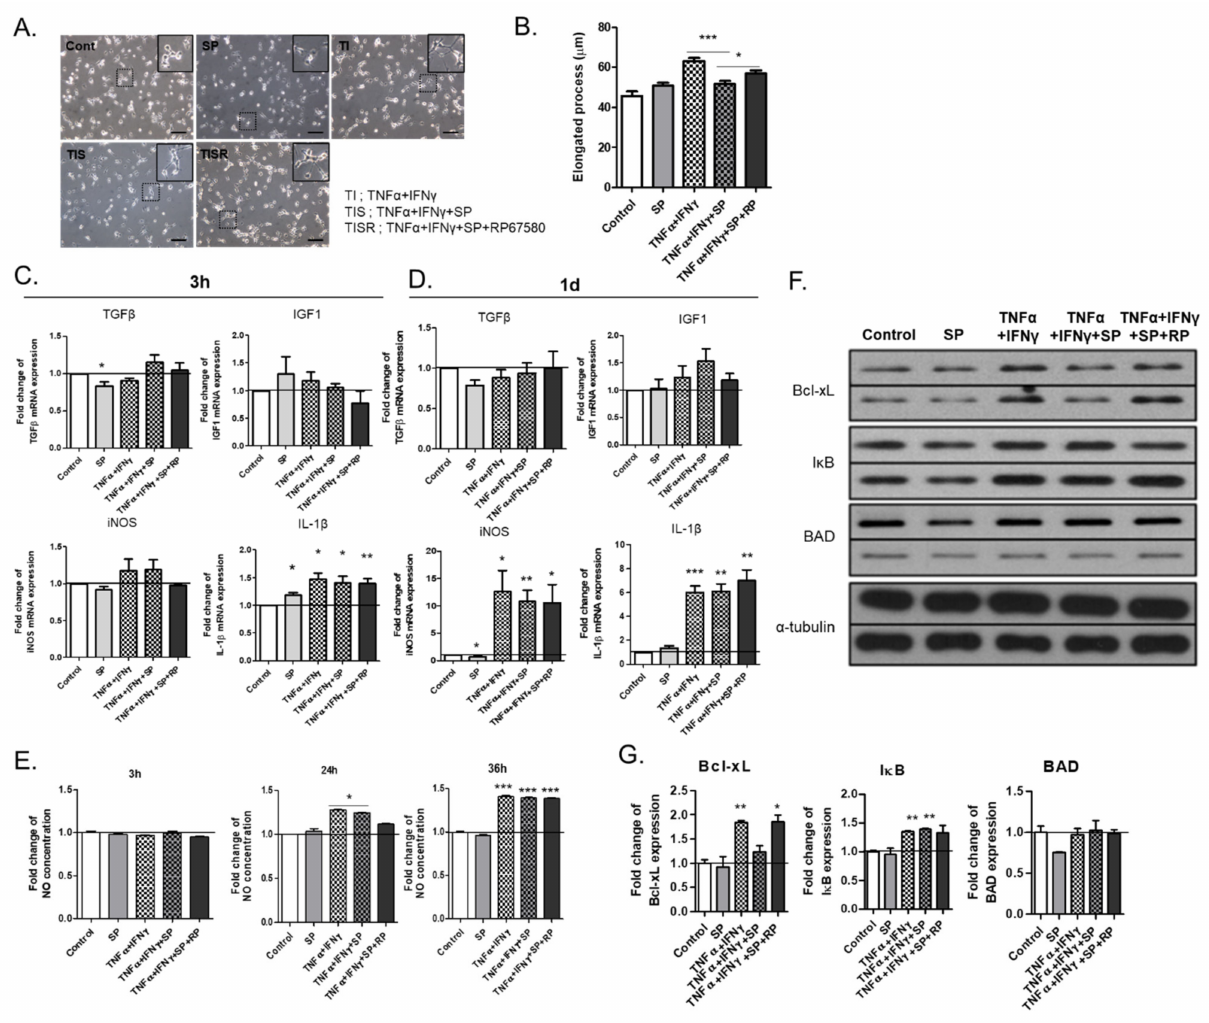
Figure 5. M1 polarization of MG d14 induced by treatment with TNF- α and IFN- γ : ( A ) Bright field images of microglia cultured with TNF- α and IFN- γ ; microglia cultured with TNF- α , IFN- γ , and SP; and microglia cultured with TNF- α , IFN- γ , SP, and RP67580 (RP, an NK1 receptor antagonist). ( B ) quantitative data for elongated processes of microglia under various cytokine treatments; ( C , D ) quantitative data for mRNA expression of TGF- β , IGF1, iNOS, and IL-1 β at 3 h after treatment ( C ) and one day after treatment ( D ) ( n = 3). Black line: 1x baseline of mRNA expression; ( E ) Quantitative data of NO production in various cytokine combinations at different time points ( n = 3). Black line: 1x baseline of NO concentration; ( F ) the Western blot analysis of Bcl-xL, I κ B, and BAD in microglia cultured with TNF- α , IFN- γ , SP, and RP67580; ( G ) quantitative data of Bcl-xL, I κ B, and BAD expression ( n = 3). Black line: 1x baseline of protein expression. * p < 0.05, ** p < 0.01, and *** p < 0.001; scale bar = 100 µ